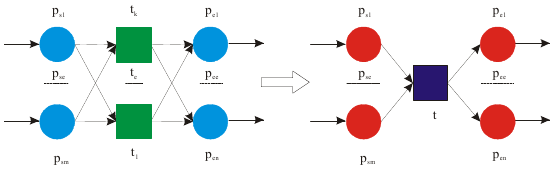
Fig.14. Overlapping transitions reduction rule The overlapping transitions reduction process in